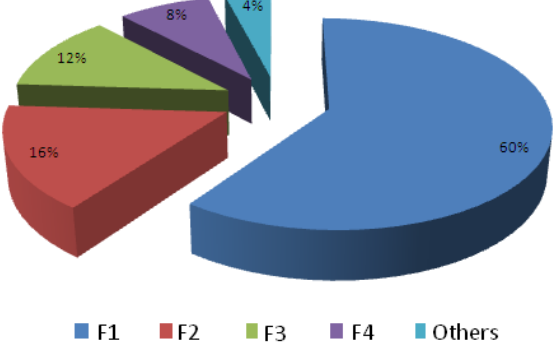
Figure 1. The percentage usage of foundation lotions of various brands among a group of undergraduate female students of an engineering college at West Bengal, India. Population size was 200, age group 19–23 years. The selected cosmetics were abbreviated as F1–F4.